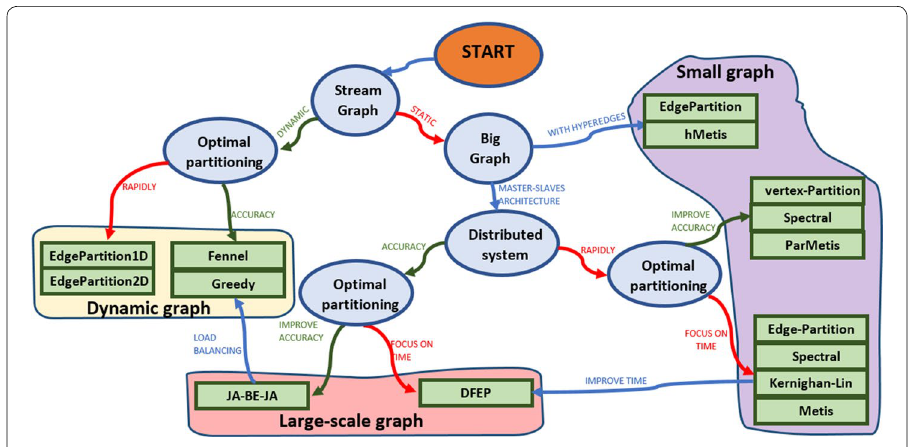
Fig. 5 Roadmap of graph partitioning